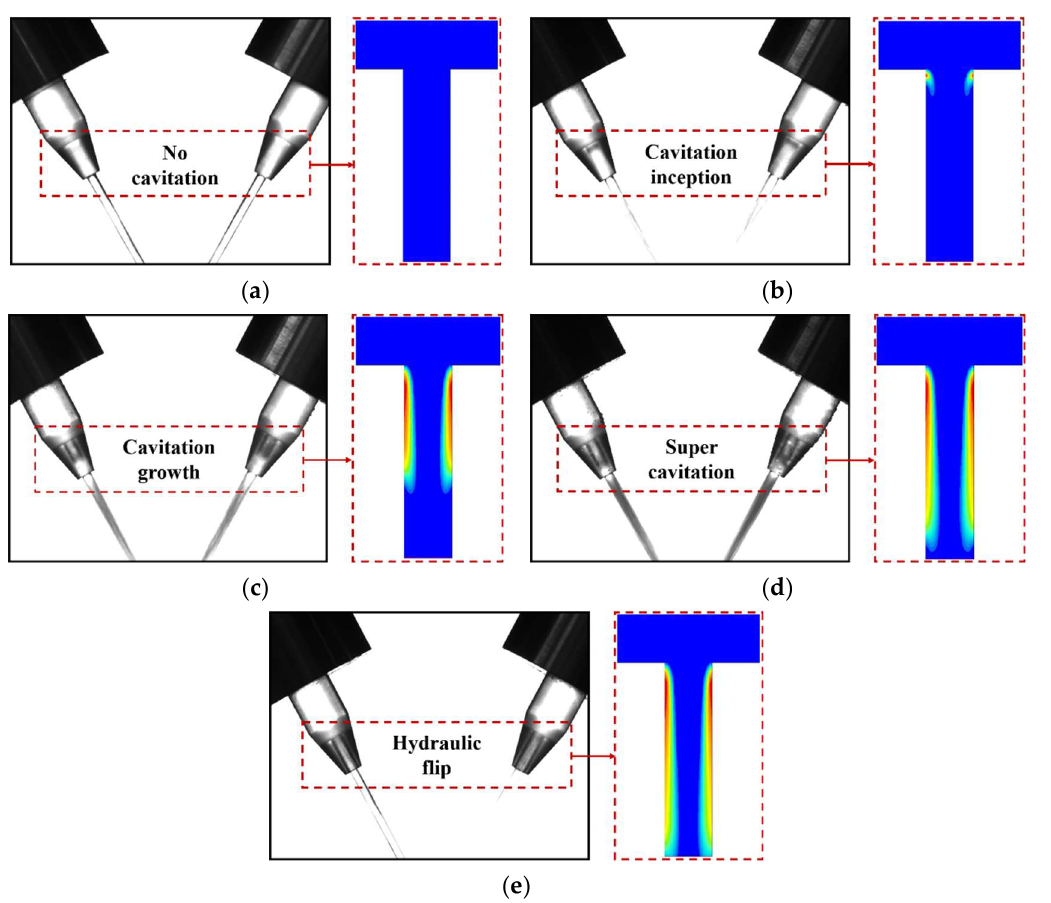
Figure 9. Cavitation simulation and experimental comparison of 1 mm diameter orifice under dif- ferent injection pressures: ( a ) 0.2 MPa; ( b ) 0.3 MPa; ( c ) 0.4 MPa; ( d ) 0.5 MPa; and ( e ) 0.8 MPa.